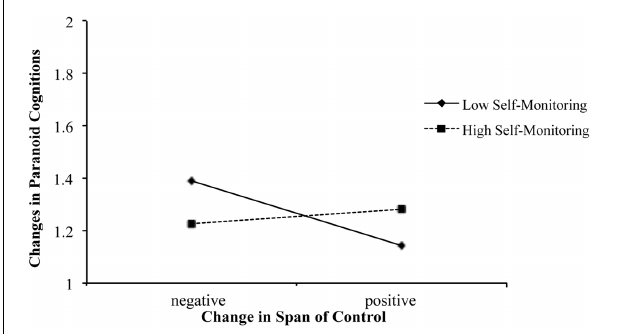
FIGURE 2 | The interactive effects of changes in span of control and self-monitoring on changes in paranoid